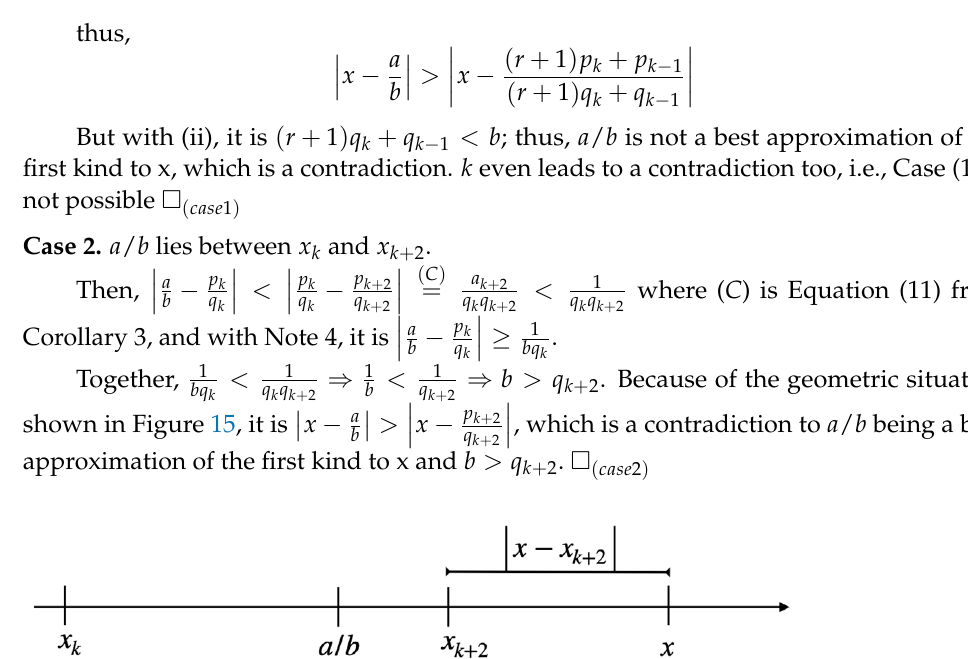
Figure 14. Distances within an interval of semiconvergents (k odd).